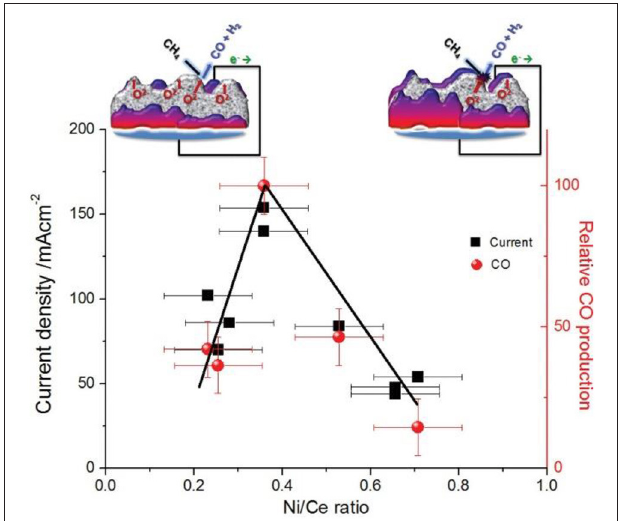
FIGURE 13 | Current and CO production as a function of surface composition. The current flowing at the SOEA (left y-axis) and the relative carbon monoxide production (right y-axis) as a function of the Ni/Ce ratio measured by in situ APPES. Measurements are performed on samples with identical nominal composition, but subjected to different pretreatments in the cell prior to the measurements. In all cases ceria and nickel exist exclusively in the Ce 3 + and Ni 0 oxidation states. The error bars represent estimated uncertainty based on the photoelectron peak area and mass spectrometry signal calculations. Lines serve as guides to the eye. Conditions : anodic polarization ( + 1V), atmosphere: 0.1 mbar CH 4 , temperature: 700 ◦ C. The schematic shows the proposed surface arrangement in the case of a low (left) and a high (right) Ni/Ce ratio (ceria in gray and nickel in purple color). Reprinted with permission from Vorontsov et al. (2008).